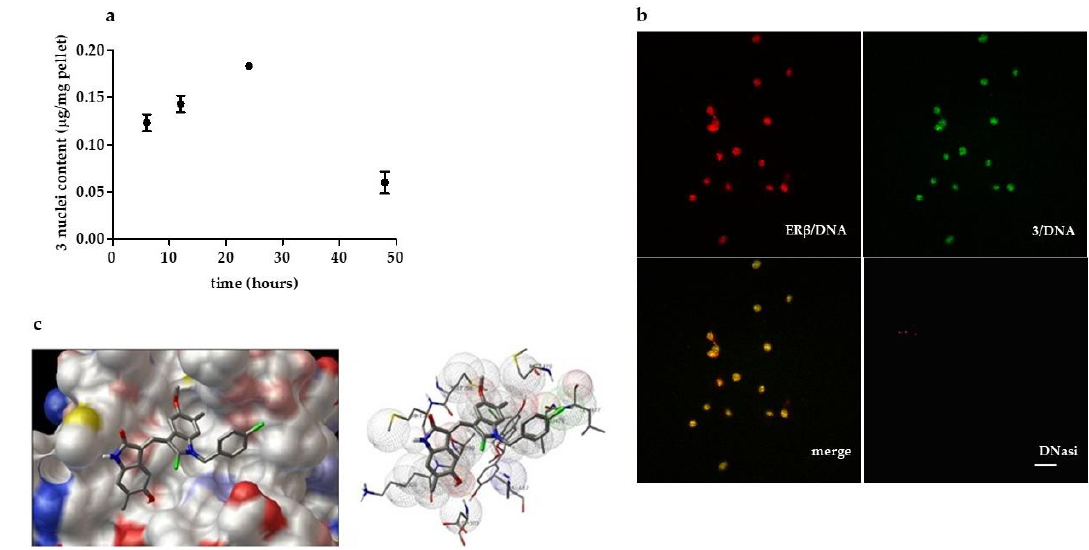
Figure 4. Nuclear localization, ERβ on chromatin colocalization, and molecular docking: ( a ) Nuclear content profile of compound 3 at different incubation times ( n = 3). The results are obtained by analyzing the sample in SIM modality on the ESI generated ions at m/z 493 and the quantitation results from the total of cis and trans content. ( b ) ERβ/ 3 complex binds chromatin. Yellow pixels represent ERβ/ 3 colocalization. In the negative control, lysis was followed by DNase I treatment. Bar = 20 µm. ( c ) The images show the lowest energy conformation of compound 3 into the ERβ binding site: (left) the best docking binding pose of compound 3 is shown into the pocket binding site of ERβ; and (right) the amino acid residues of the ERβ binding site within 5 Å from compound 3 are displayed.